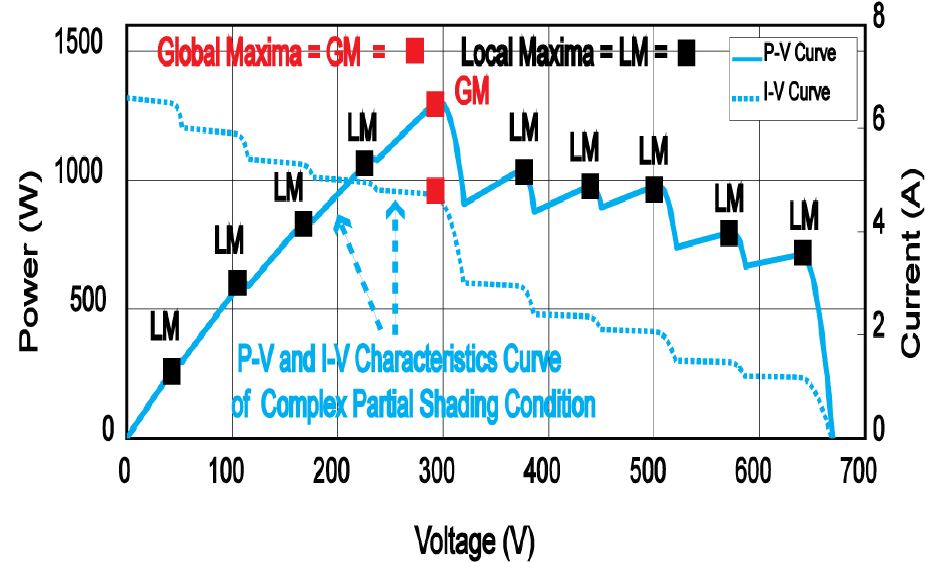
Figure 12. P-V and I-V Characteristics Curves for Complex Partial Shading